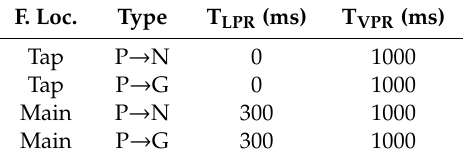
Table 6. Fault recovery times.